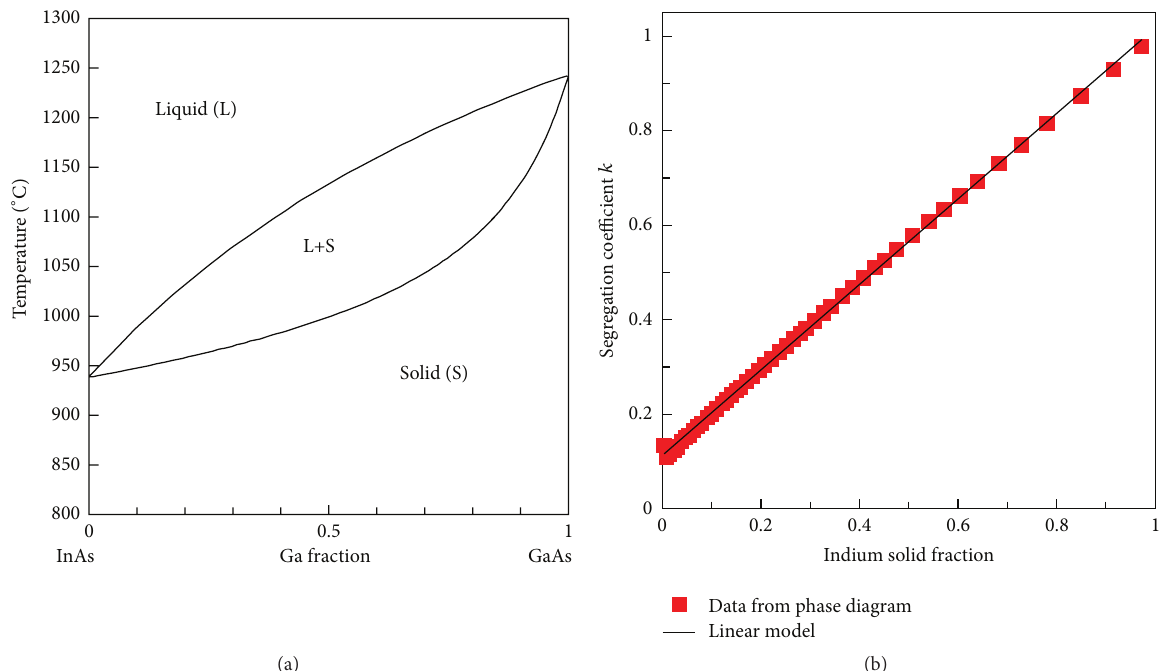
Figure 2: (a) Phase diagram of InGaAs. (b) Segregation coefficient is a linear function of indium solid concentration from phase